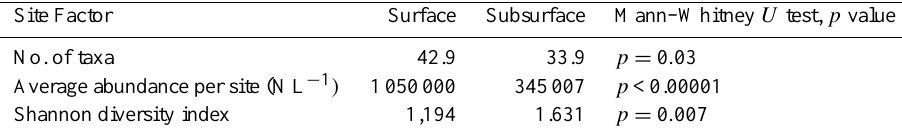
Table 3. Summary of the differences between key community parameters in the subsurface and subsurface samples. The subsurface samples were not further subdivided into different depths for the analysis, N = 66 (surface = 23, subsurface =